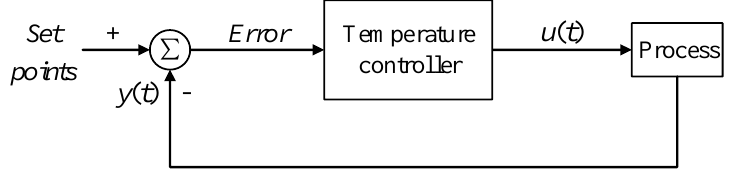
Figure 3 . Level-2 module-based process control solution.